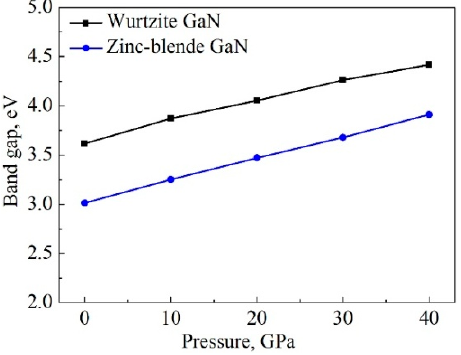
Figure 8. Band gaps of two GaN structures at different pressures.